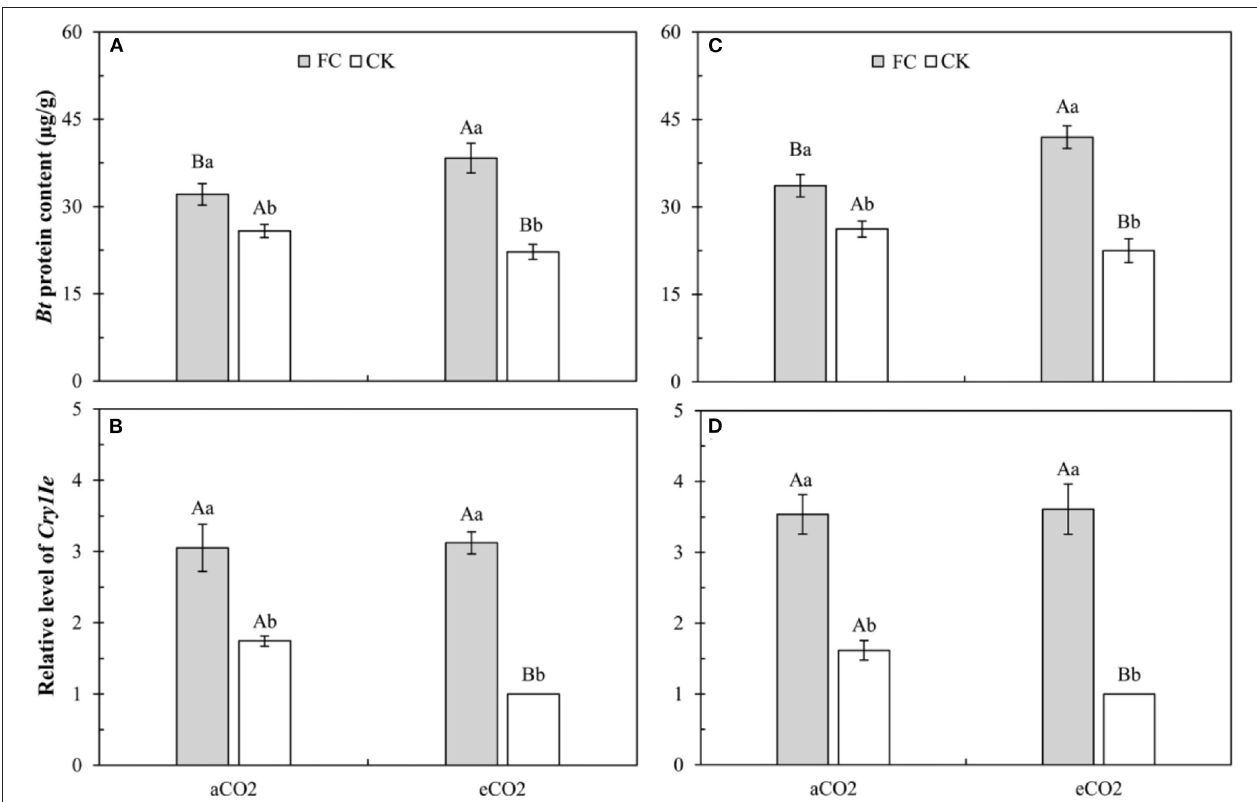
FIGURE 2 | Effects of the inoculation with arbuscular mycorrhizal fungi (AMF), F. caledonium , on foliar Bt protein content and Bt gene relative expression level in leaves of Bt maize under ambient CO 2 ( a CO 2 ) and elevated CO 2 ( e CO 2 ) at the heading stage (BBCH-59) in 2017 (A,B) and 2018 (C,D) . (Note: Different uppercase and lowercase letters indicate a significant difference between a CO 2 and e CO 2 , and between F. caledonium inoculation and non-inoculation of F. caledonium under the same other conditions as revealed by Tukey’s test) ( P < 0.05; n =